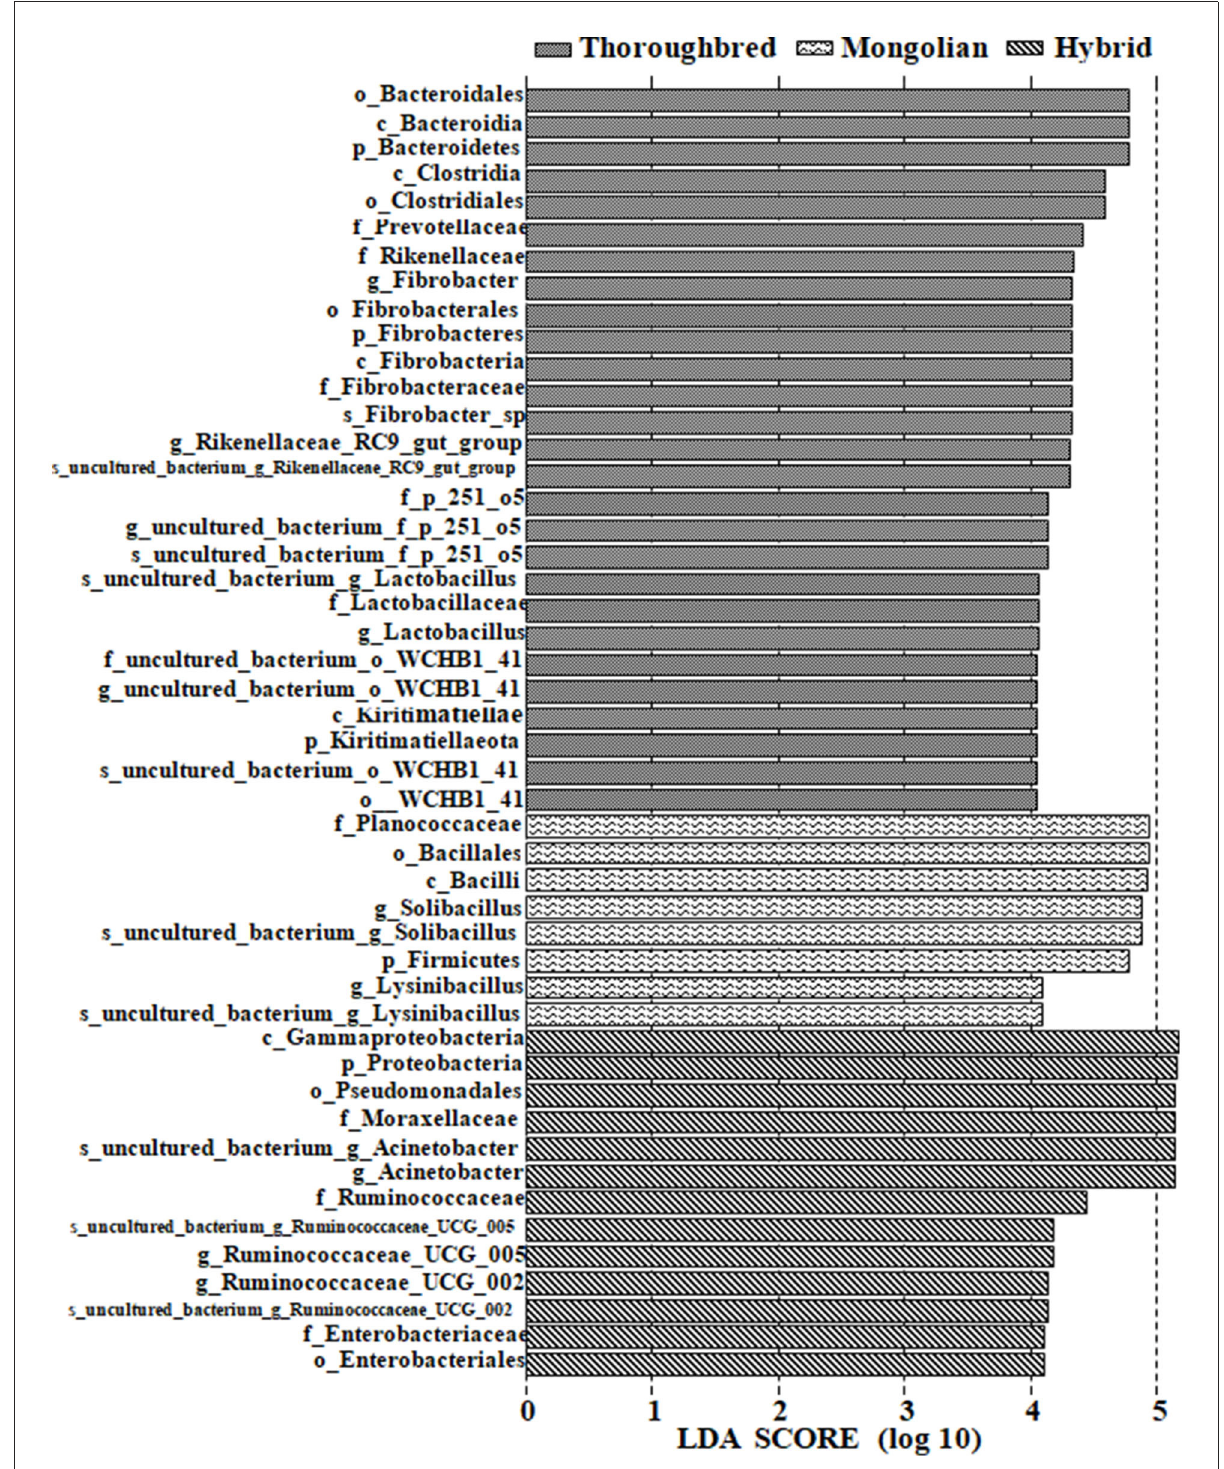
FIGURE6 LEfSe [linear discriminant analysis (LDA) effect size] analysis of samples between groups (pairwise Wilcoxon test, LDA scores >